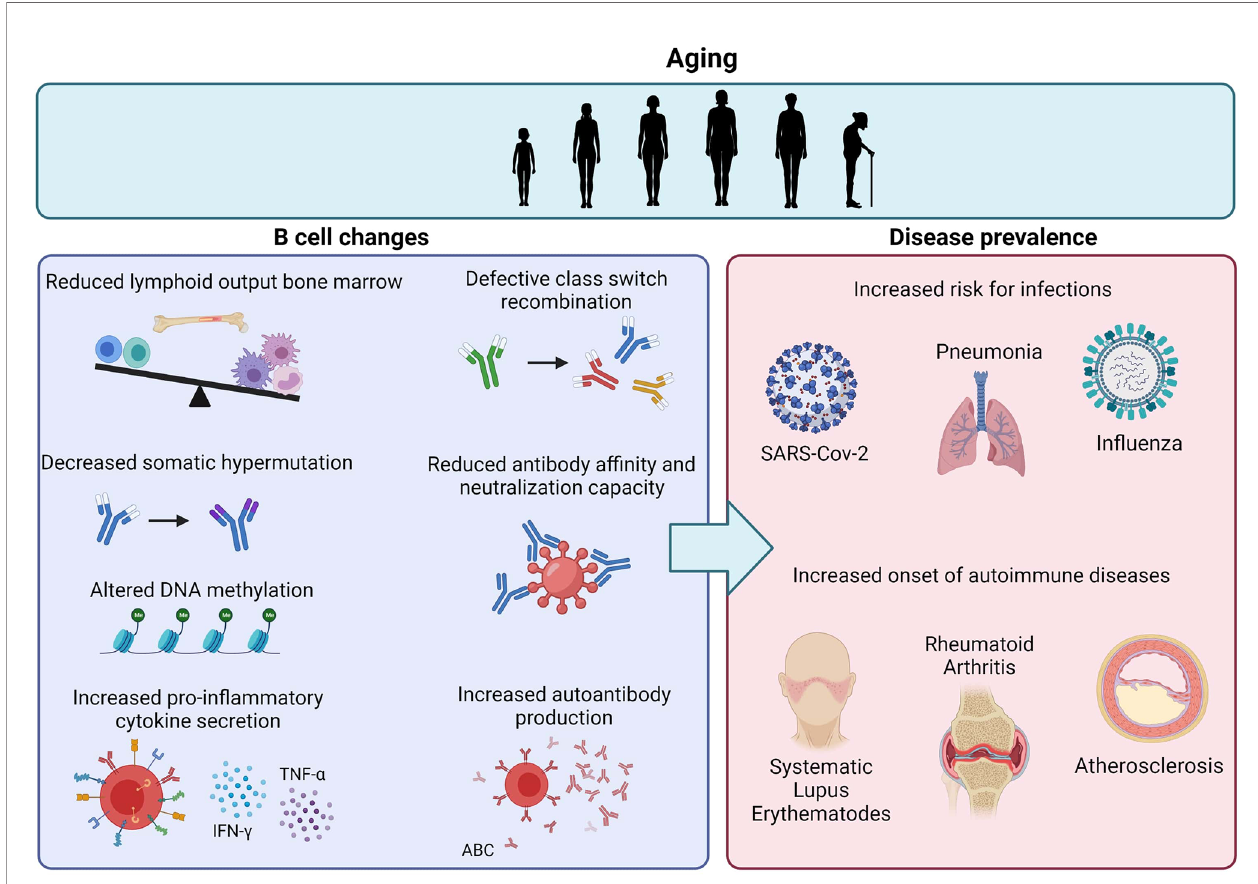
FIGURE 1 | Age-related effects on B cells and the impact on disease prevalence. Aging is associated with reduced lymphoid output in the bone marrow and intrinsic defects in B cells, including decreased CSR, SHM and antibody af fi nity. The increase in ABCs also results in increased pro-in fl ammatory cytokine secretion and autoantibody reduction. Together, these age-related B cell changes contribute to the increased risk for infections and autoimmune diseases upon